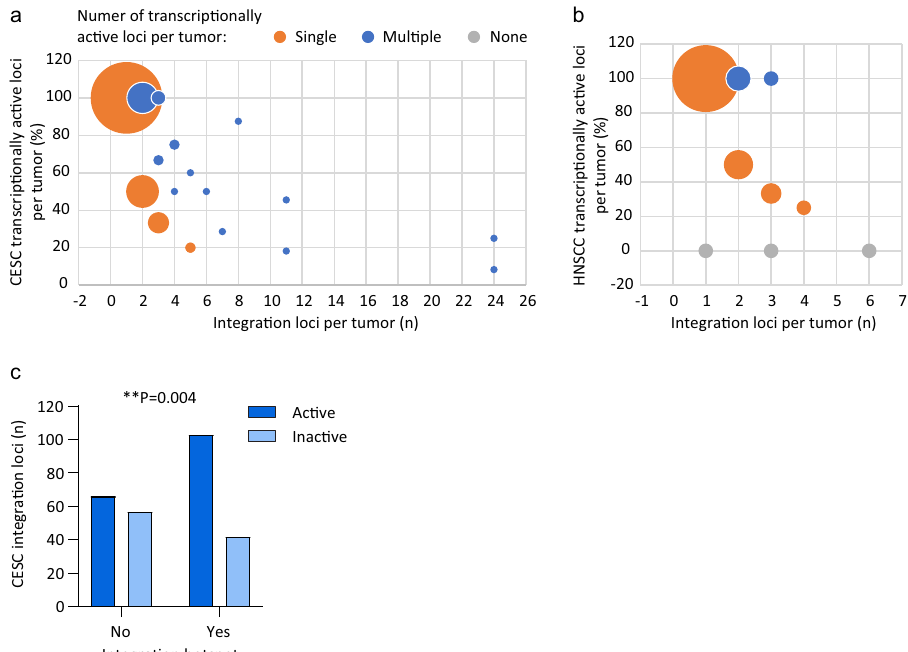
Fig. 3 Transcription status of integrated viral genomes. a , b Bubble graph showing the percentage of transcriptionally active integration loci per tumor in CESC ( a ) and HNSCC ( b ) samples relative to the number of integration loci per tumor; 100% indicates that all integration loci are active in that tumor. Orange, blue and gray circles represent tumors with a single, multiple or no transcriptionally active loci, respectively. Circle size indicates the number of samples per grouping (for CESC, largest, n = 86 and smallest, n = 1; for HNSCC, largest, n = 21 and smallest, n = 1). Three HNSCC samples ( TCGA-CR-6482 , TCGA-CN-5374 , and TCGA-CR-7404 ) were reported as integration negative from RNA-seq 32 but had a single or multiple integration loci detected through WGS 5 and were therefore classi fi ed as transcriptionally inactive. c Bar chart showing the number of CESC integration loci that are transcriptionally active or inactive for viral oncogene expression at integration hotspots. Association between viral oncogene transcription and integration hotspots was based on a Fisher ’ s exact test (two-tailed; ** P <